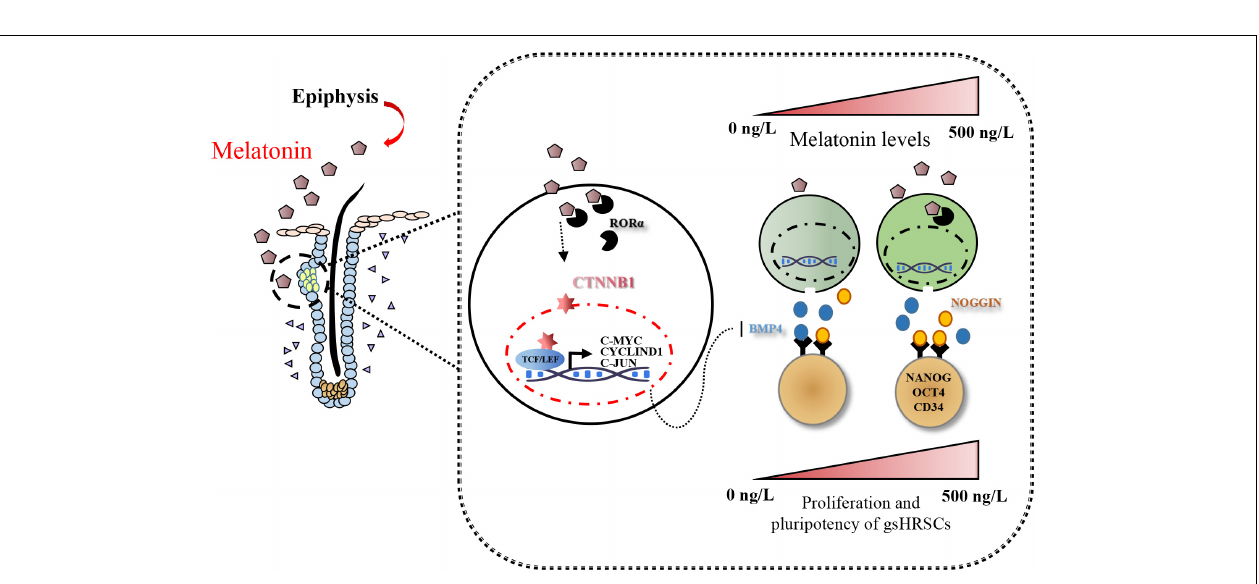
FIGURE 6 | Protein levels of CTNNB1, BMP4, NOGGIN, NANOG, OCT4, and CD34 were detected after exposure to 500 ng/L melatonin with or without NOGGIN overexpression as shown by immunofluorescence staining at 72 h. Scale bar, 50 µ m.